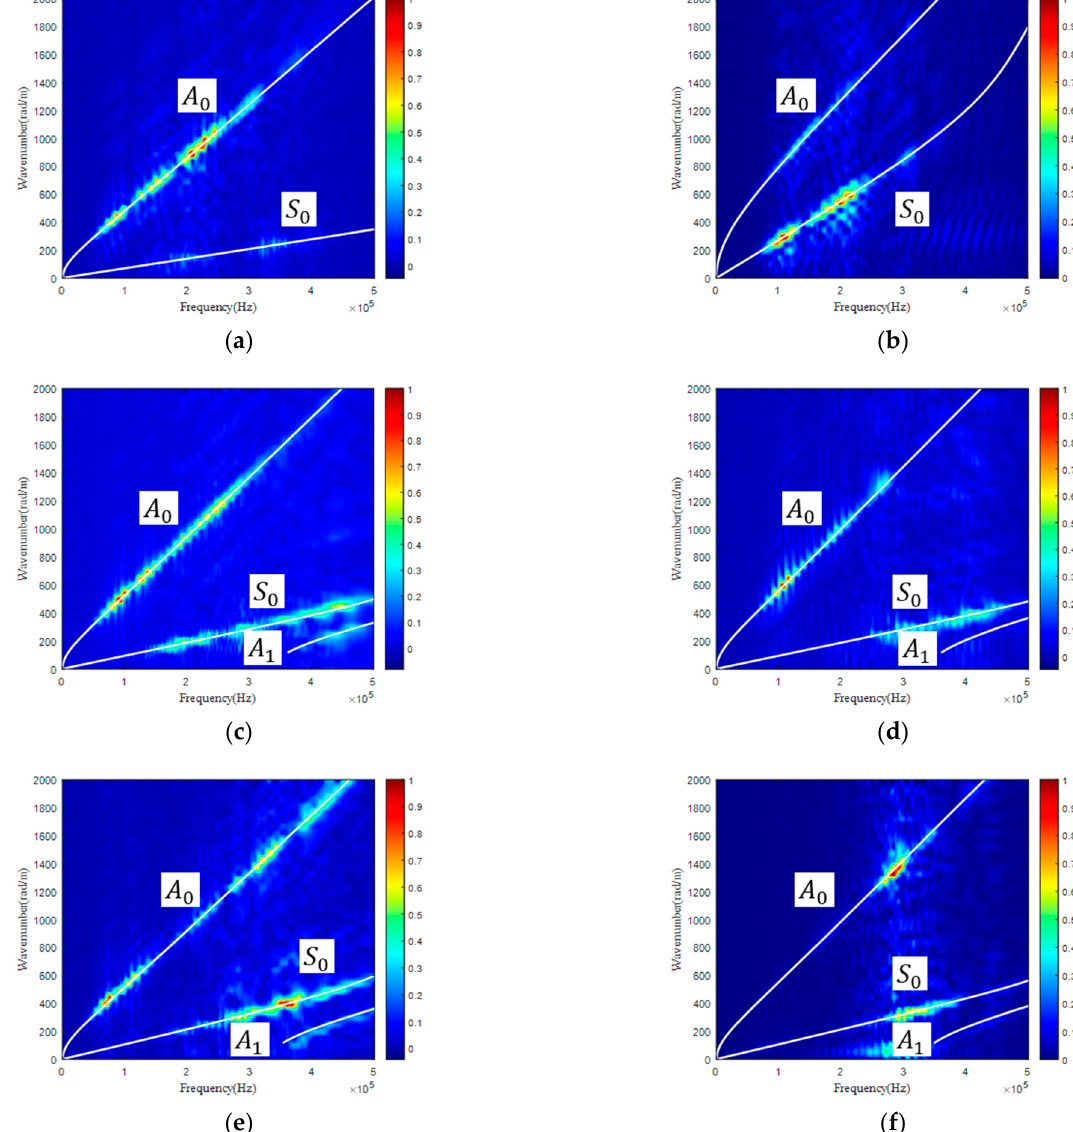
Figure 9. Experimentally obtained frequency and wave number contour superposed with the GW dispersion curve calculated with the reconstructed stiffness matrix: UD along ( a ) 𝑥 direction and ( b ) 𝑧 direction; CP along ( c ) 𝑥 direction and ( d ) 𝑧 direction; QI along ( e ) 𝑥 direction and ( f ) 𝑧 direction.